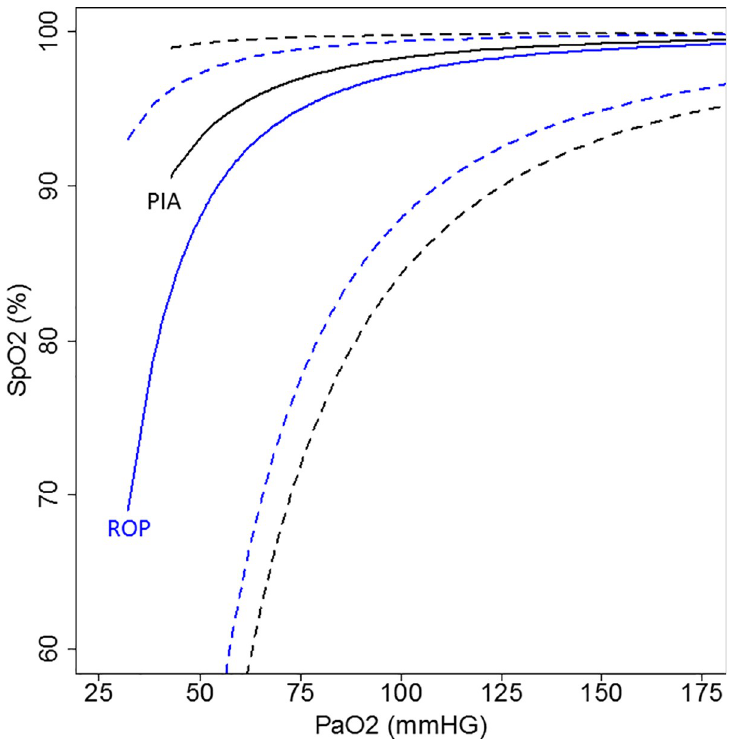
Fig 3. Multilevel analysis of the Prospective Inpatient Acutely ill and Retrospective Outpatient Pulmonary cohort. PIA, Prospective Inpatient Acutely ill cohort. ROP, Retrospective Outpatient Pulmonary cohort. The black curve represents the Prospective Inpatient Acutely Ill cohort with a 95% prediction interval (black dashed line). The blue curve represents the Retrospective Outpatient Pulmonary cohort with a 95% prediction interval (blue dashed line).